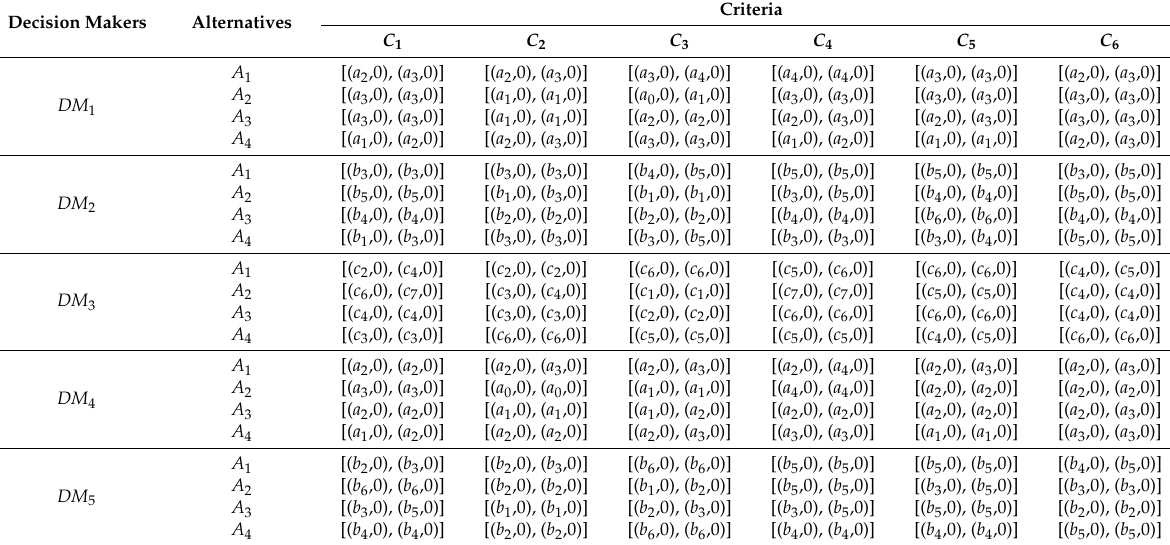
Table 3. Interval 2-tuple decision matrix.